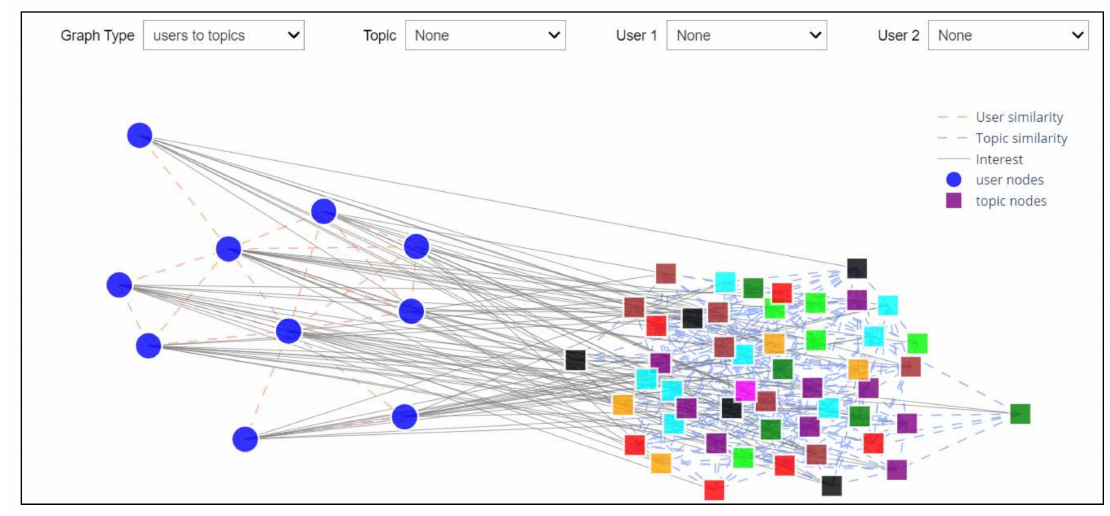
Figure 11. The sample of Heterogeneous Graph in Plotly Library.